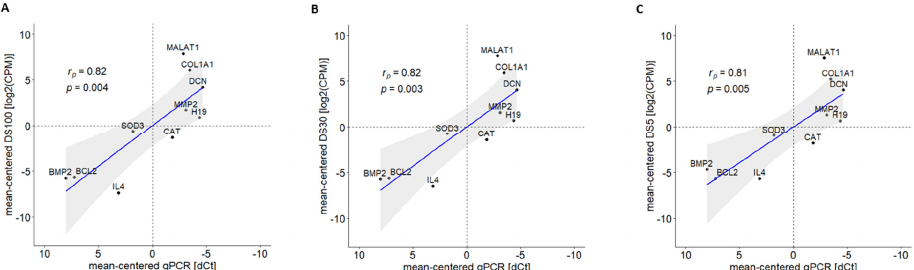
Figure 3. Correlation analysis of gene expression levels obtained from qRT-PCR and ONT sequencing using ( A ) DS100, ( B ) DS30, and ( C ) DS5. Interleukin 4 (IL4), metastasis associated lung adenocarcinoma transcript 1 (MALAT1), collagen type I alpha 1 chain (COL1A1), decorin (DCN), matrix metallopeptidase 2 (MMP2), h19 imprinted maternally expressed transcript (H19), catalase (CAT), superoxide dismutase 3 (SOD3), BCL2 apoptosis regulator (BCL2), and bone morpho-genetic protein 2 (BMP2) genes were selected, and qPCR experiments were performed. Pearson correlation coefficients (r p ) between log 2 (CPM) and dCt were computed and reported with the respective p -value ( p ).